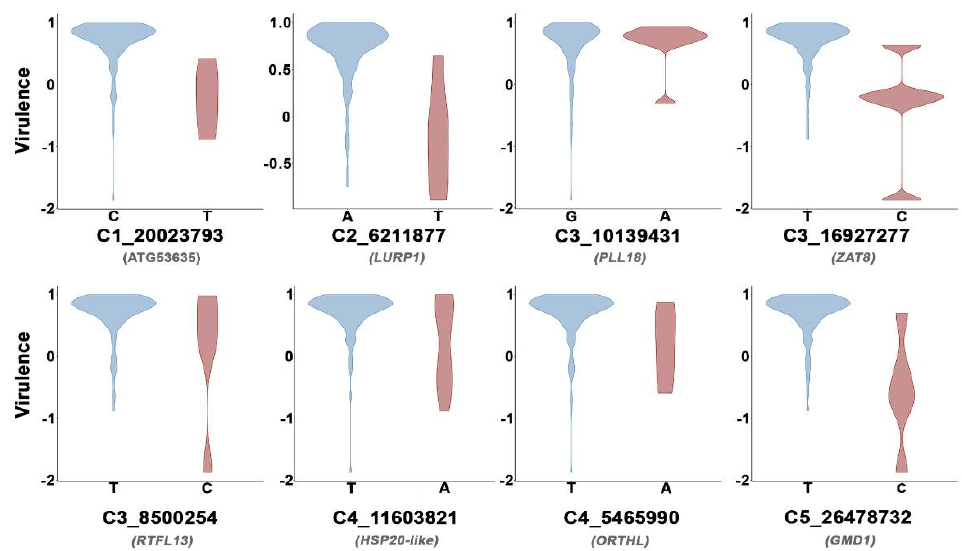
Figure 5. Distribution of CMV virulence across Arabidopsis genotypes harboring major (blue) and minor (red) variants of the eight SNPs strongly associated with this trait. Each SNP is indicated by the chromosome (C) and the position in which it is located, and the corresponding gene is shown in grey.